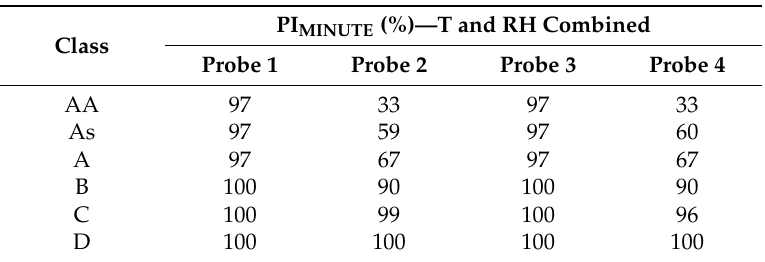
Table 8. Performance Index (PI) calculated as the percentage of time for which the combination of T and RH data fits into the specifications of each ASHRAE climate class in the case of one-minute